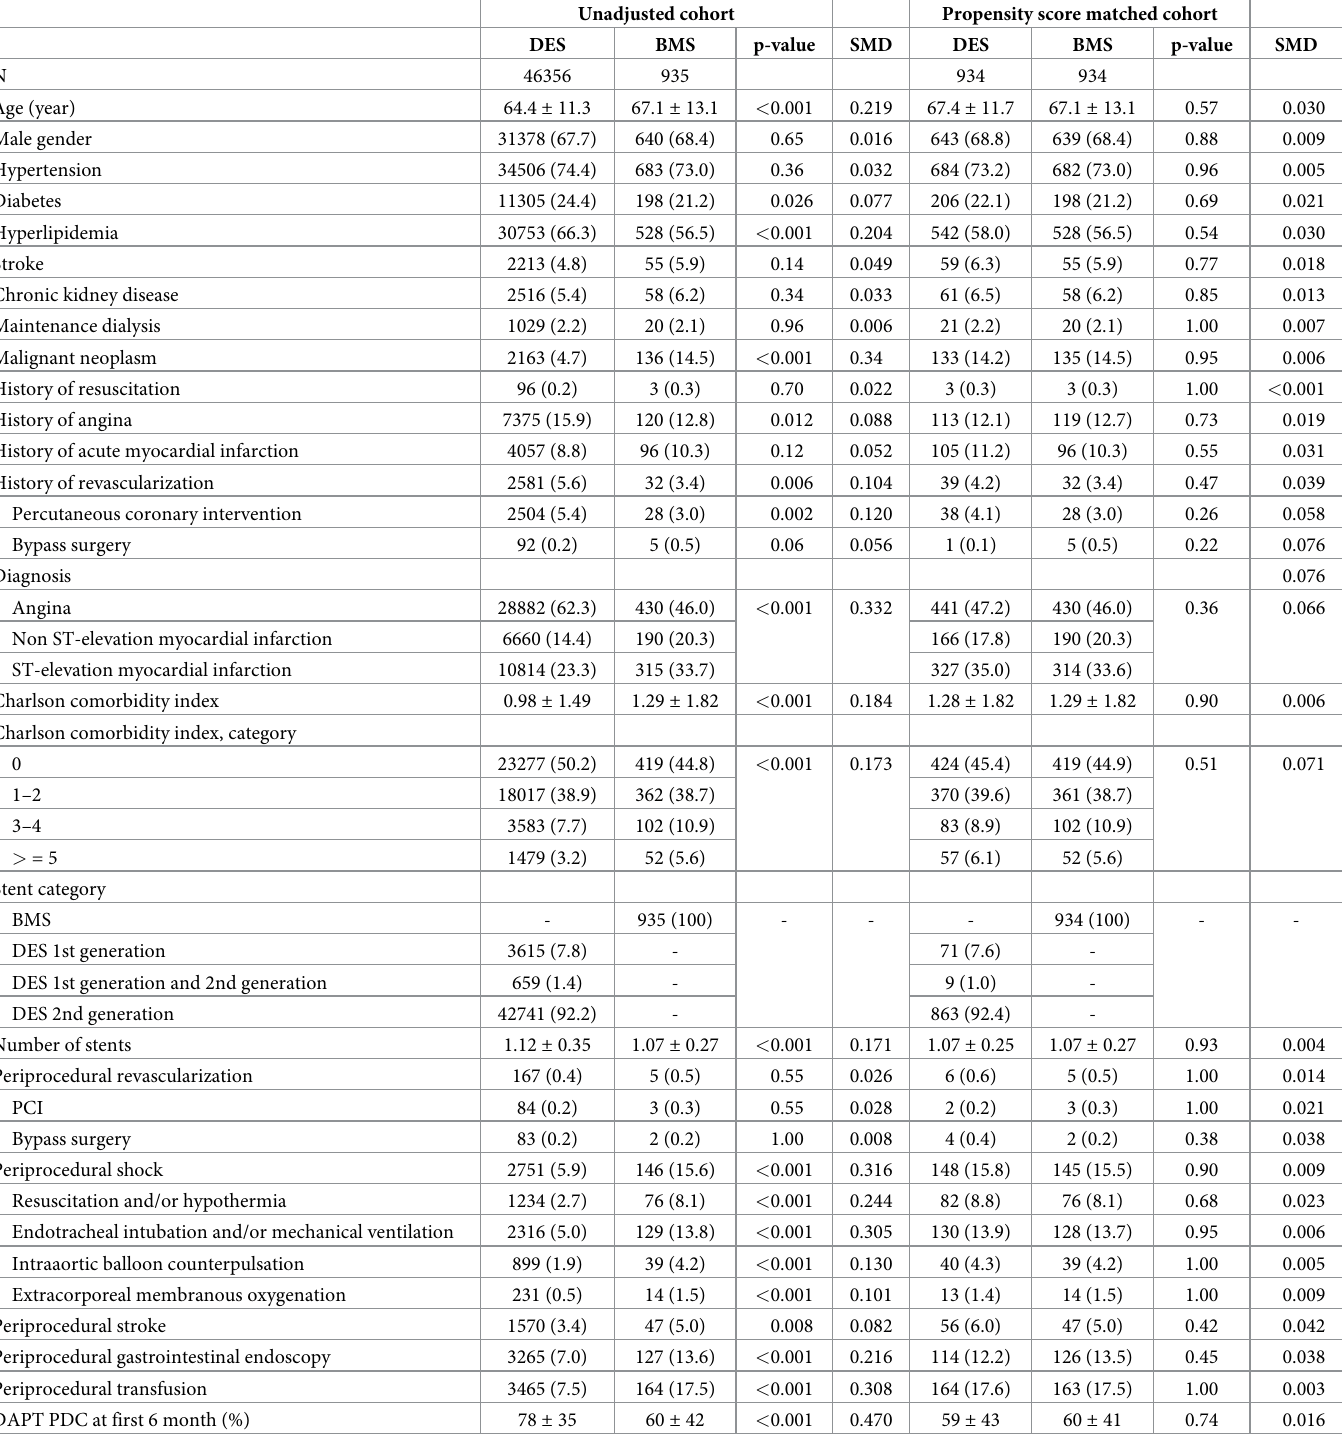
Table 1. Basal clinical and procedural